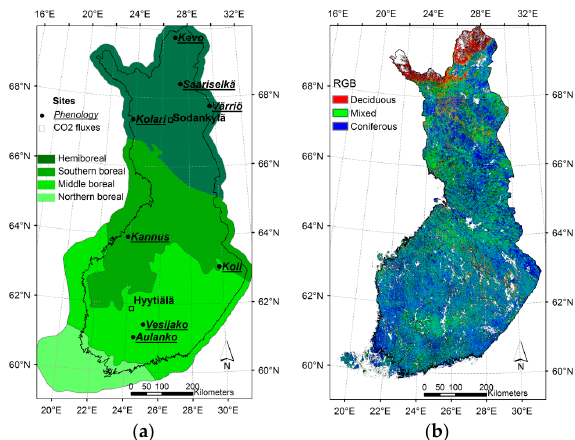
Figure 1. ( a ) CO 2 flux measurement sites, phenological sites and phytogeographical zones in Finland according to Ahti et al. (1968) ( b ) Red-Green-Blue (RGB) image of forest cover fractions determined from CORINE land cover 2000.